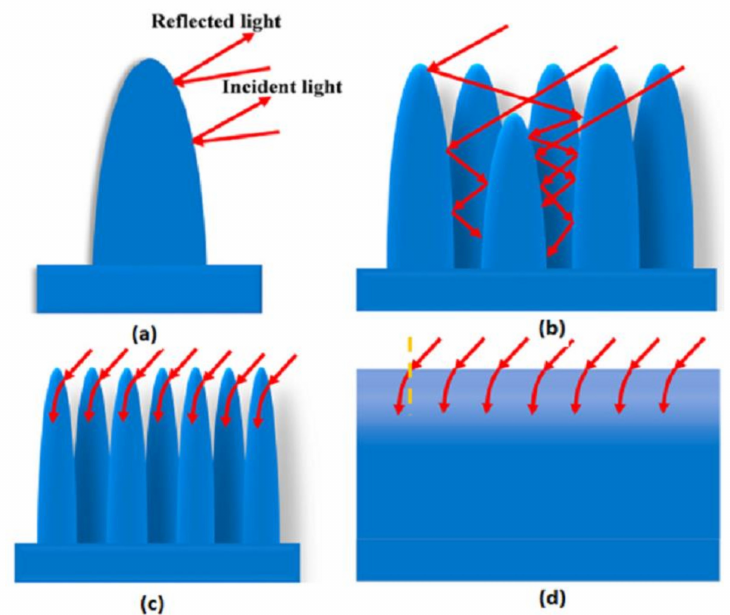
Figure 6. ( a ) Light interaction with macrostructure. ( b ) Multiple internal reflections resulted due to microstructure arrays. ( c ) Light interaction with nanostructure array. ( d ) Light interaction with GRIN structure resulting in bending of light rays. Reprinted with permission [36]; 2019,